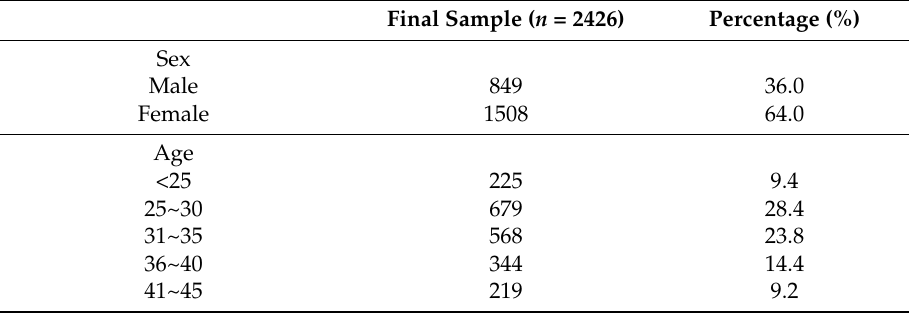
Table 2. Demographic characteristics of the final sample with information of the